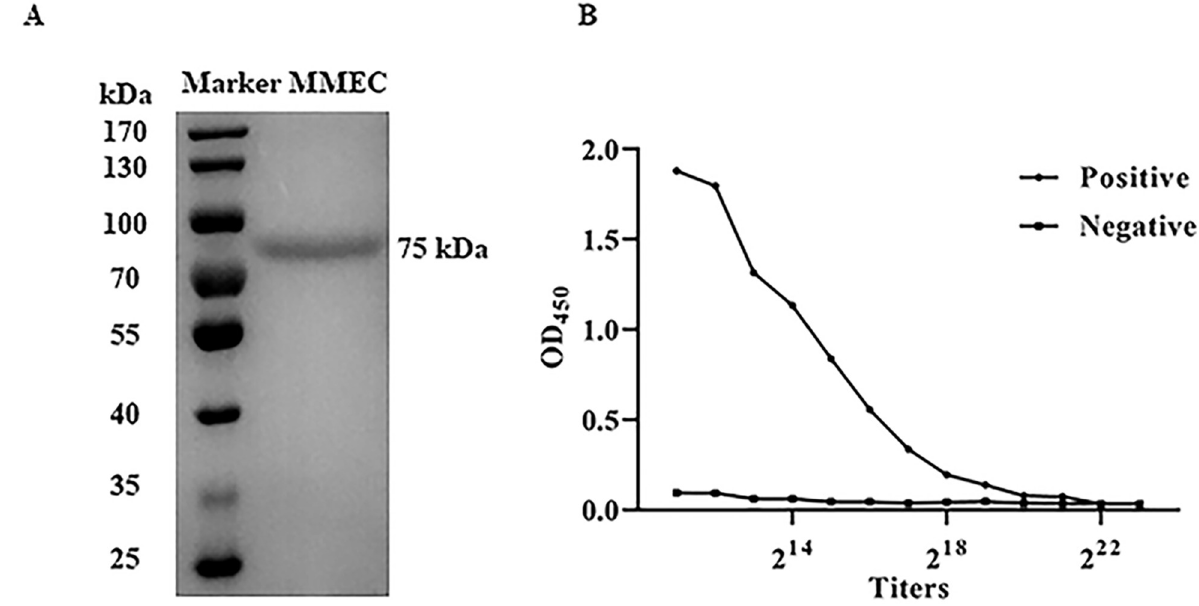
Fig 1. Preparation of the coating fusion antigen and HRP-labeled fusion protein AG. A: The coated fusion antigen MMEC made from MPB70, MPB83, ESAT6, and CFP10 with the size of 75 kDa was checked by 10% SDS-PAGE; B: The titers of HRP-labeled fusion protein AG made from Staphylococcal protein A and Streptococcal protein G was determined by iELISA.